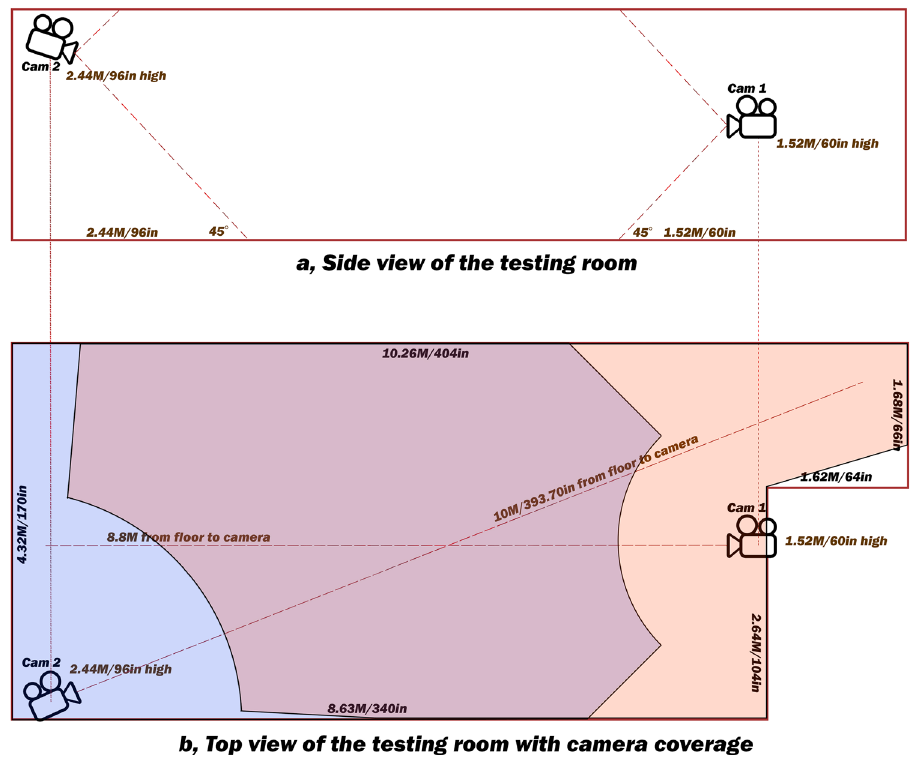
Figure 3. Overview of the testing room geometry and cameras’ locations. This figure demonstrates a two- camera setup that could catch any fall in any place inside the room (supported by our test set). ( a ) Side view. The lower boundary for fall detection was set to be aligned to the lower edge of the camera viewable area to maximize the widest detection. Complicated calibration was not necessary. ( b ) Orientation of the cameras for the testing site and their monitoring areas. The dotted lines extending from the camera lenses indicate where the fall tests were performed. Orange on the right is the inactive zone for Cam 1. Blue on the left is the inactive zone for Cam 2. Purple in the middle is the zone where falls are detected by both cameras. Precision and recall are increased in the purple zone. The presence of two cameras with this setup allows falls in any location in this room to be